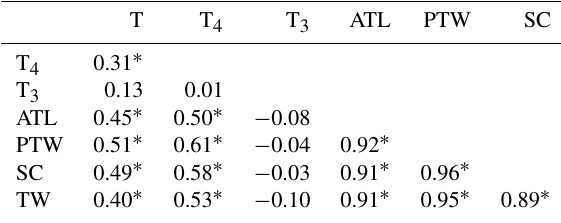
Figure 4. Age-related distribution of average testicular weight in male Murrah buffaloes ( n = 103). Table 1. Pearson’s correlation between testosterone (T), thyrox- ine (T 4 ), triiodothyronine (T 3 ), average testes length (ATL), paired testes width (PTW), scrotal circumference (SC), and testicular weight (TW) in male Murrah buffaloes.